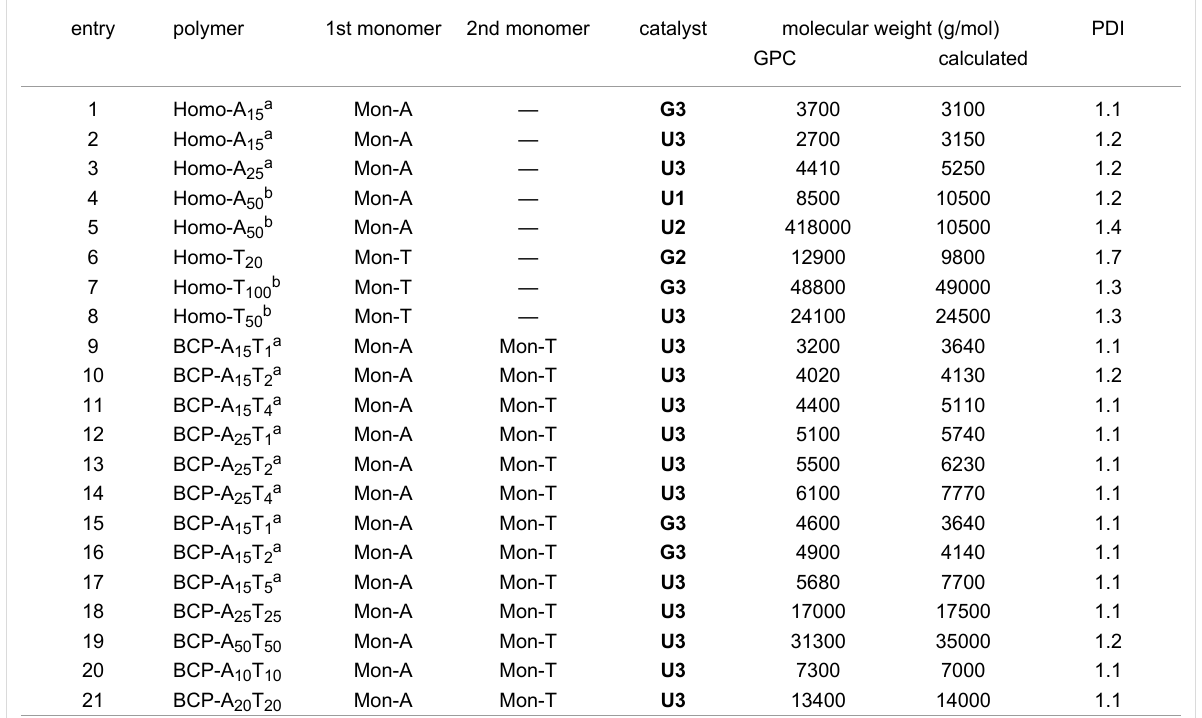
Table 1: Overview of polymerization result of monomer A 7 and monomer T 9 with the catalysts U1 – U3 and G1 – G3